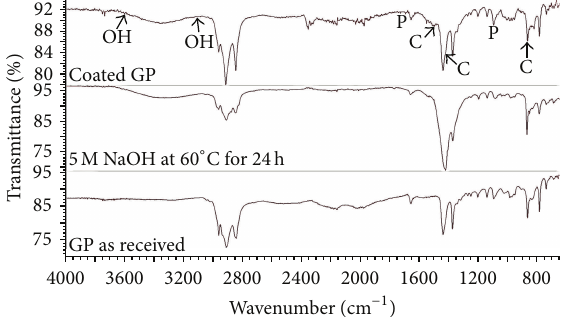
Figure 1: FTIR analysis of GP, GP treated with NaOH for 24 h, and Tas-SBF coated GP; OH: hydroxyl, C: CO 3−2 , and P: PO 4−3 .